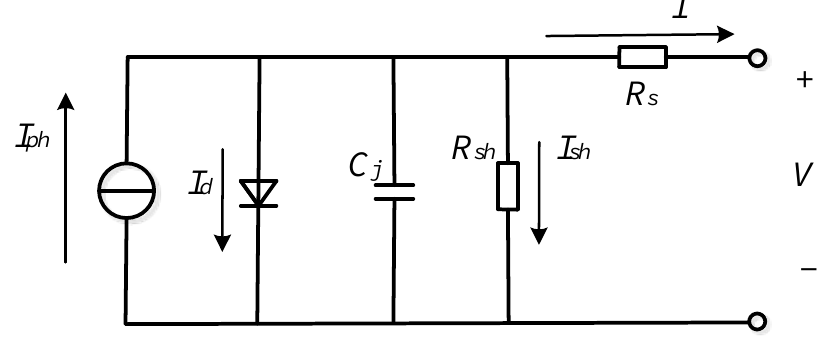
Figure 1. Photovoltaic (PV) module equivalent circuit.